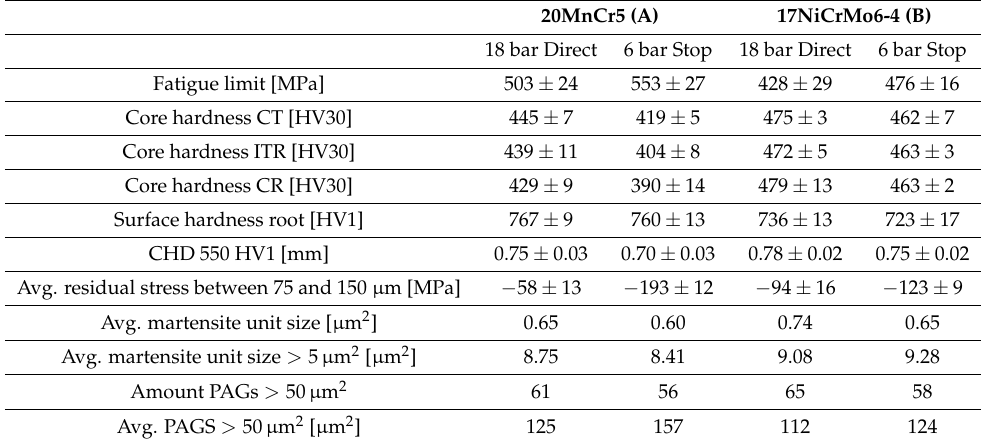
Figure 3. Vickers hardness, HV1, depth profile for 20MnCr5 (A) and 17NiCrMo6-4 (B) at gear root. Table 2. Summation of characterization results for 20MnCr5 (A) and 17NiCrMo6-4